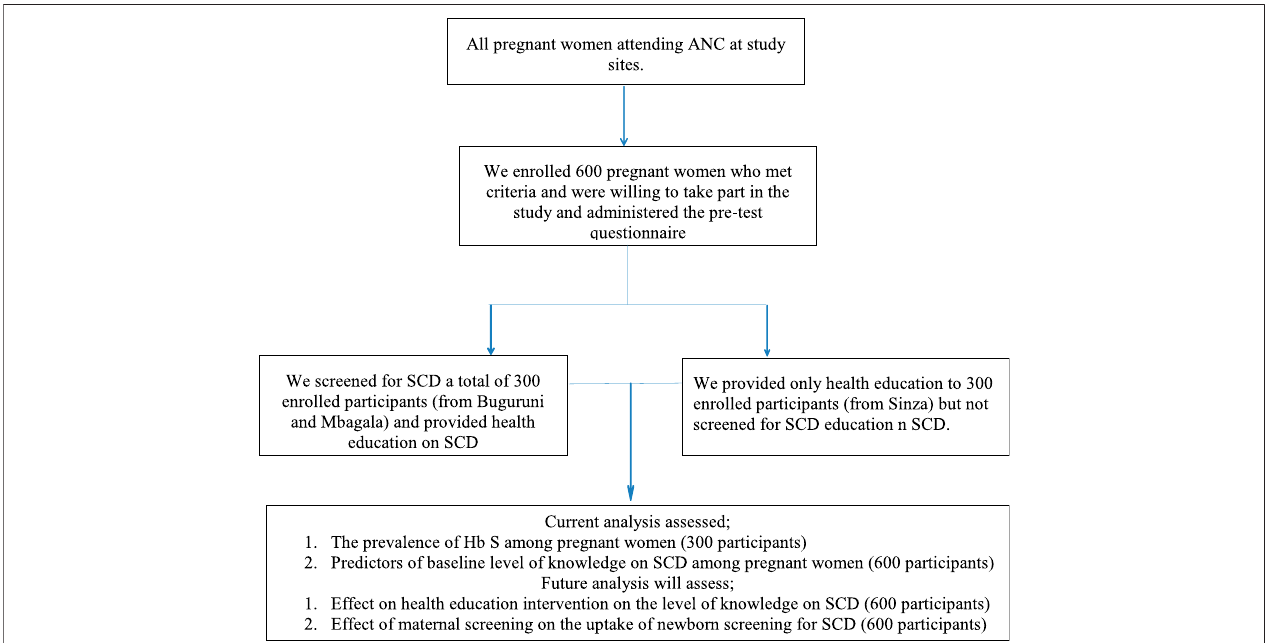
FIGURE 1 | Summary of data collection